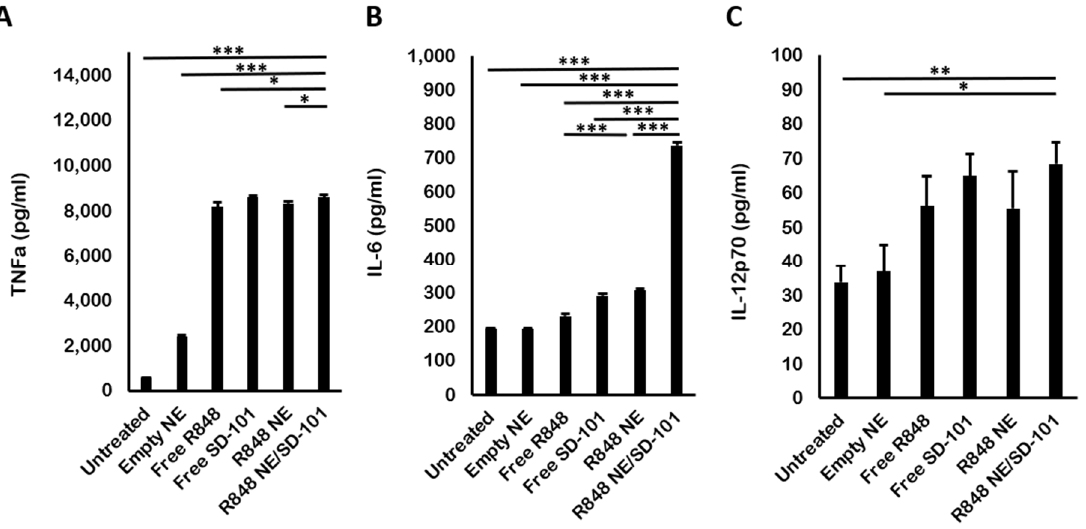
Figure 4. In vitro ELISA for cytokine quantifications. ( A ) TNFa, ( B ) IL-6, and ( C ) IL-12p70 concentrations secreted by RAW 264.7 cells after 12 h treated with complete medium-only, empty NE, free R848, free SD-101, R848 NE, or R848 NE/SD-101 combination. R848 was treated at 50 µM individually, in nanoemulsion, or in combination. SD-101 was given at 300 nM individually or in combination. One-way ANOVA: * p < 0.05, ** p < 0.01, *** p < 0.001.